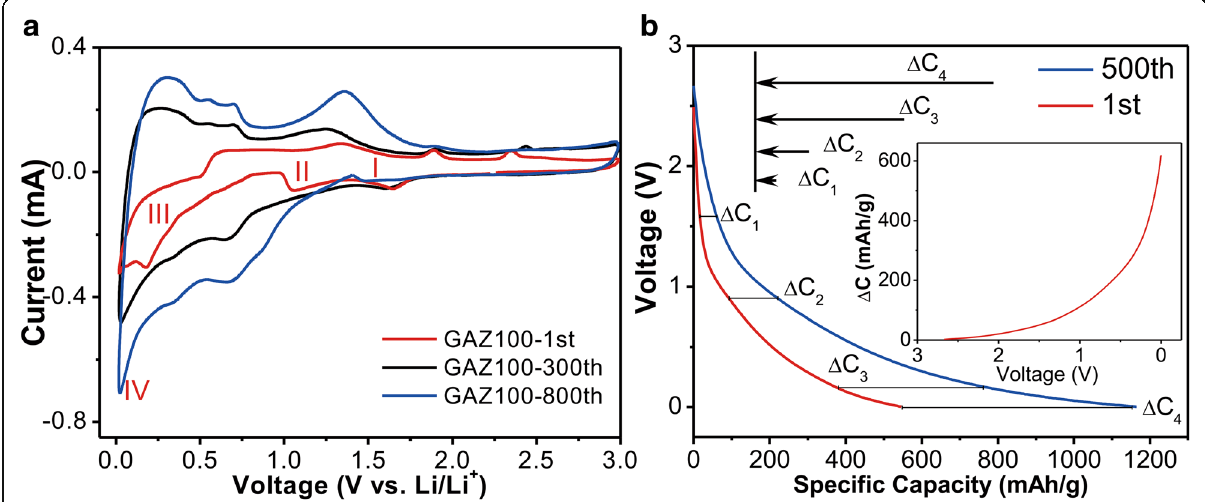
Fig. 4 a CV for GAZ100 after different charge/discharge cycles. b Selected discharge voltage profiles. Red and blue lines illustrate the discharge profiles of the 1st cycle and 500th cycle, respectively. Inset illustrates the difference of capacities between the 1st and the 500th cycles, as the function of discharge